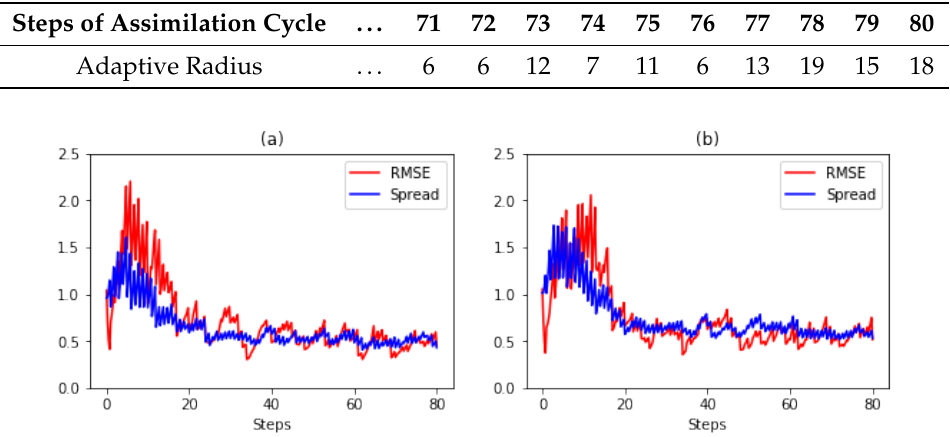
Table 2. Adaptive localization radii during the last 10 steps of the assimilation cycle.